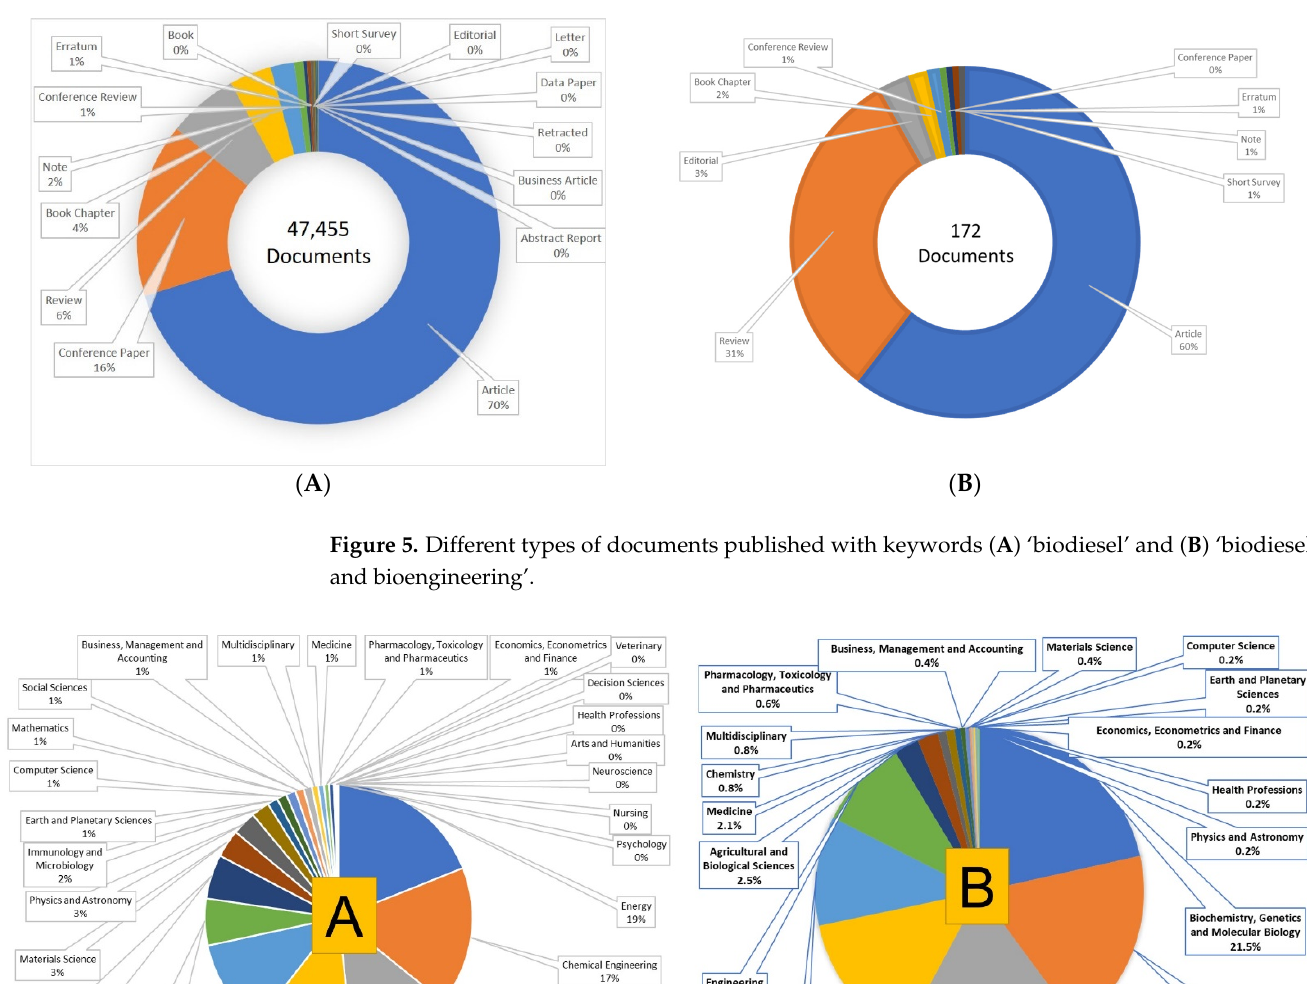
Figure 4. Patents published with different patent offices with keywords ‘biodiesel’ and ‘biodiesel and bioengineering’.